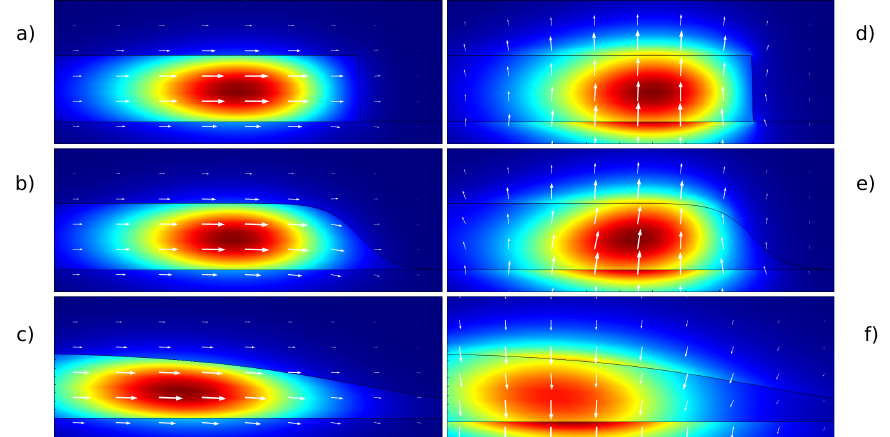
Figure 3. Electric field energy density for the first radial transverse electric, TE, ( a , b , c ) and transverse magnetic, TM, ( d , e , f ) modes for wedge angles of 89 ( a , d ), 45 ( b , e ) and 10 ( c , f ) degrees. The white arrows depict the orientation of the electric field. The resonator’s thickness is t = 400 nm.